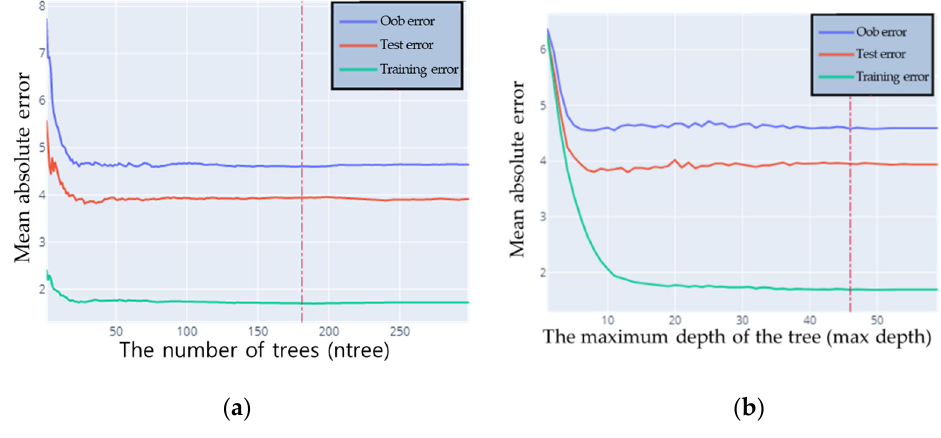
Figure 3. Hyperparameter optimization in the RF regression model: ( a ) training curves with respect to number of trees and ( b ) training curves with respect to maximum depth of trees.